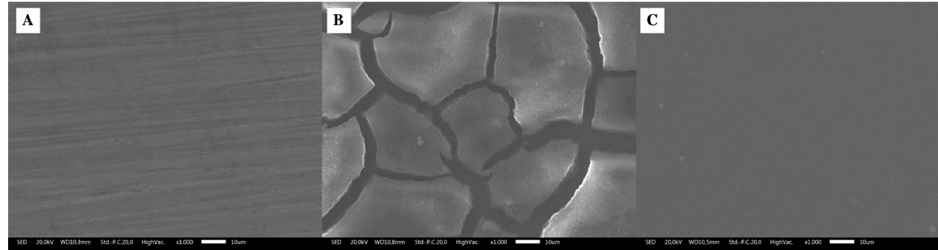
Figure 1. The SEM images of different samples ( A ) Native AZ31B; ( B ) AZ31B/TA; and ( C ) AZ31B/TA/HYA.